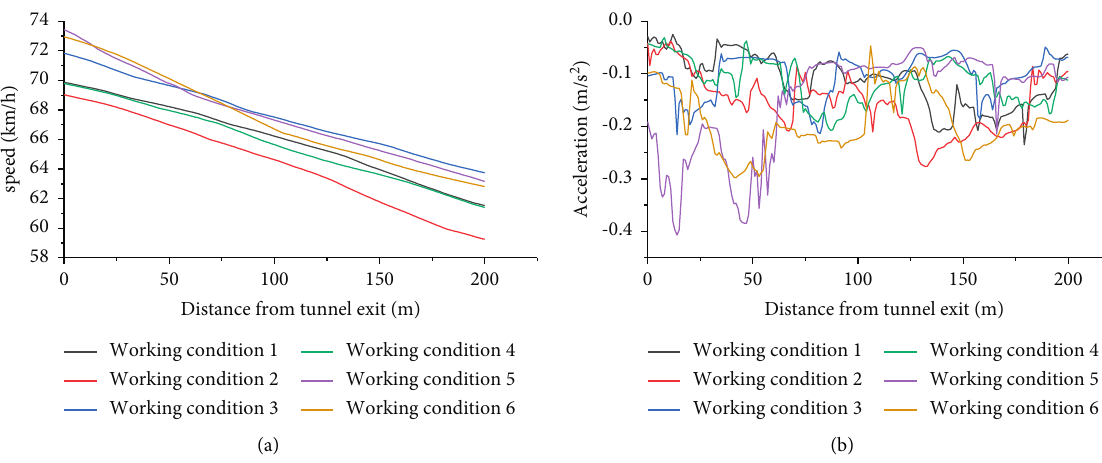
Figure 7: Vehicle speed and acceleration curves within 200m after the tunnel exit in the first service level. (a) Speed curve (b) Acceleration curve.